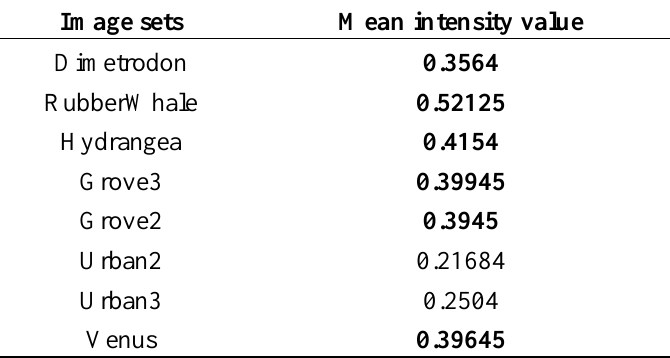
Table 4. Average intensity value of Middlebury dataset.